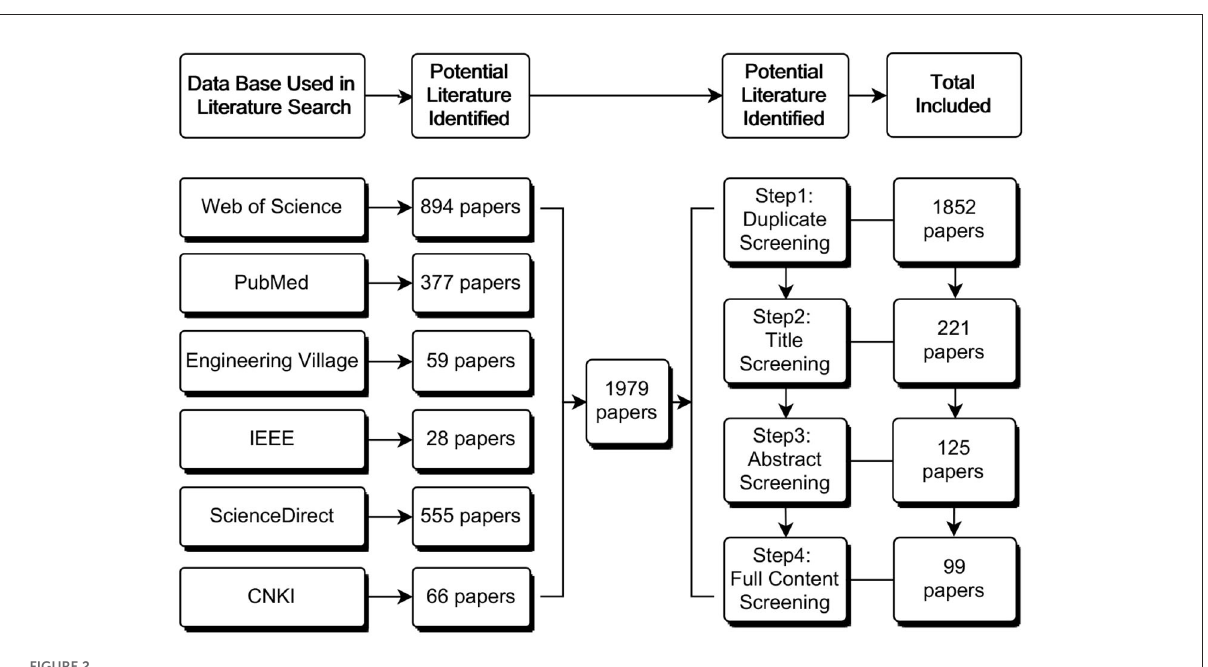
for their visual cues, which are always necessary for navigation (20), protection against predators (21, 22), reproductive success, feeding, and even growth (18). Research shows that nocturnal species are susceptible to light to the extent that even a very weak and temporary ALAN exposure can provoke subtler behavioral responses. ALAN has extensively affected migrating birds, bats, frogs, fireflies, fish, tortoises, etc. (21, 23). The products include the reduced amplitude of migration, poor visibility due to disturbed essentials of navigational signal, disorientation, collision (9, 20, 24, 25), and attraction of new species in a particular environment or repulsion of some species from their habitats. The consequences of these actions affect the foraging behaviors of organisms (26), their communication signals, and reproductive success (27,